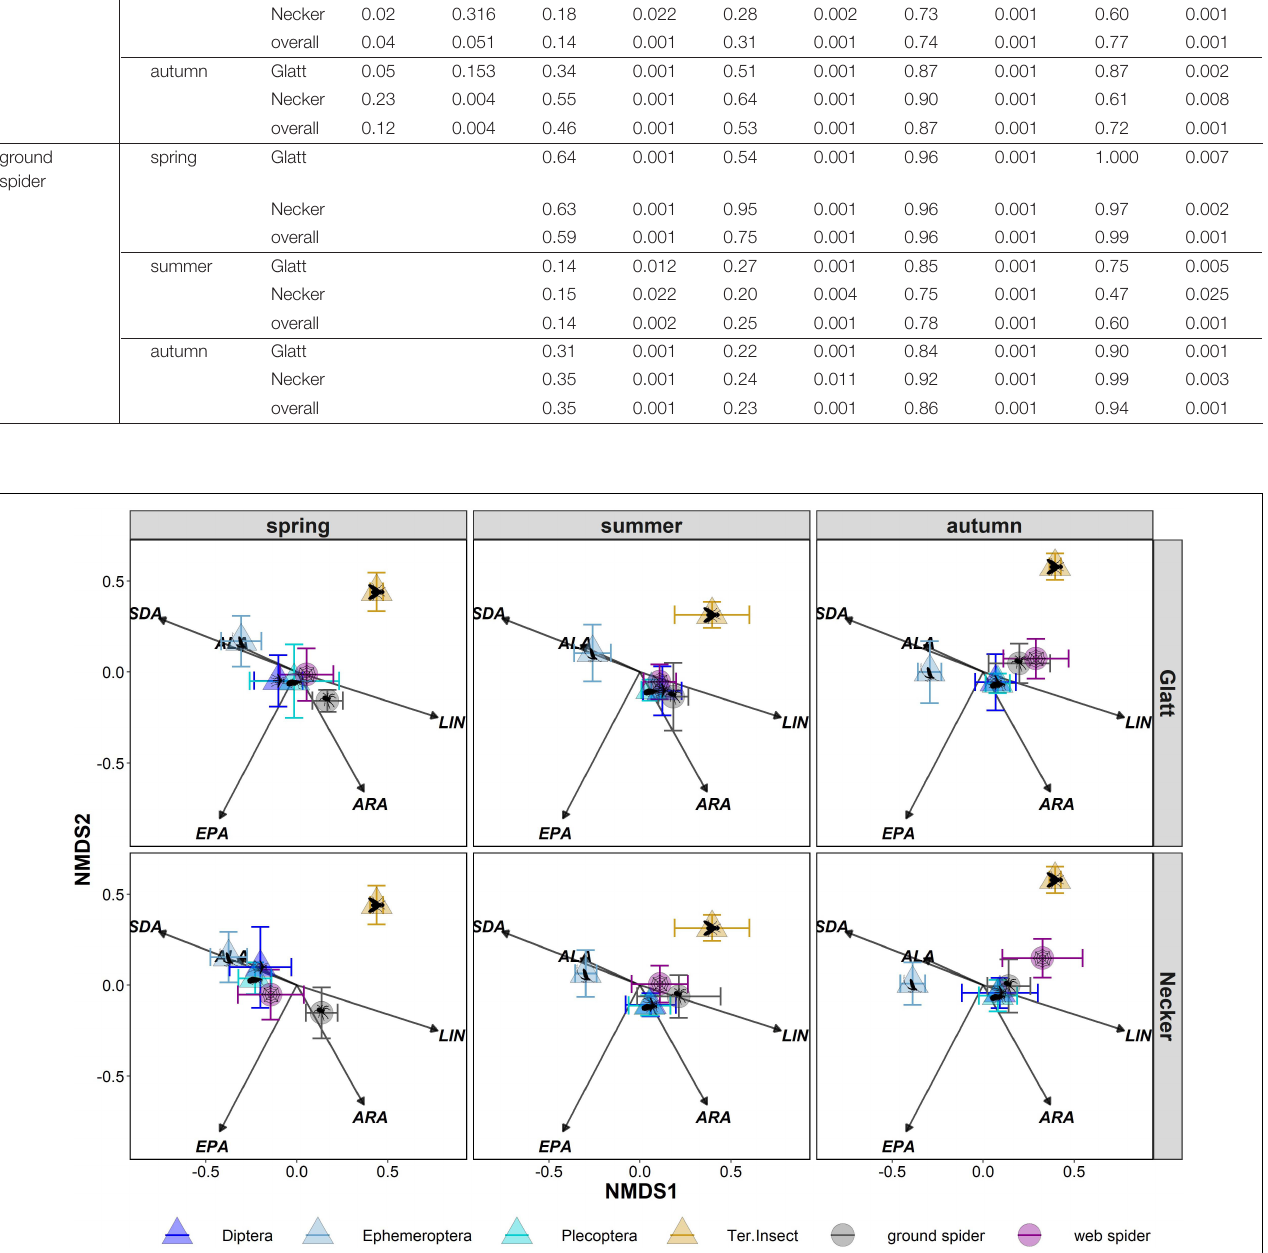
FIGURE 5 | Non-metric multidimensional scaling (nMDS) of arcsine-square-root-transformed PUFA (% of total fatty acids) of prey (aquatic Diptera, Ephemeroptera, Plecoptera and terrestrial insects) and predator groups (web spiders, ground spiders). Stress level = 0.15. Points represent means and error bars represent standard deviation. Results were divided post hoc by stream and season. LIN , linolenic acid; ALA , alpha-linolenic acid; SDA , stearidonic acid; ARA , arachidonic acid; EPA , eicosapentaenoic acid.